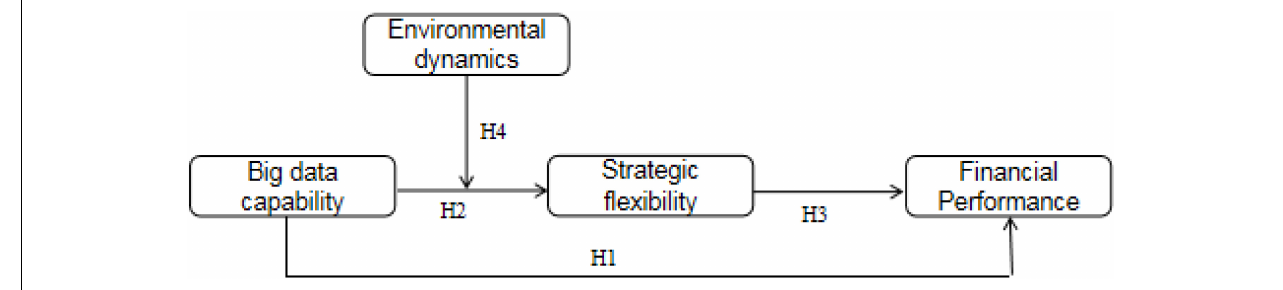
FIGURE 1 | Research